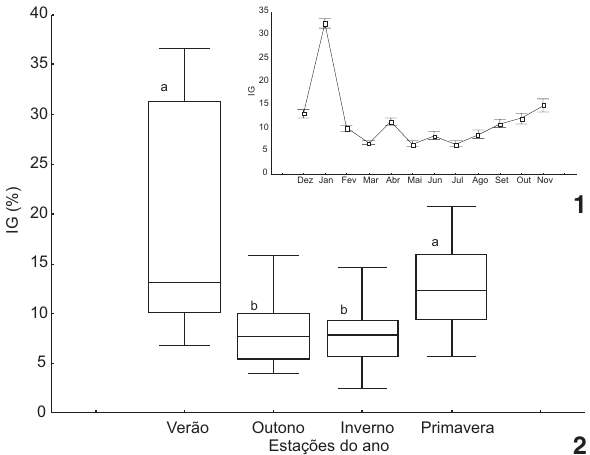
Figuras 1-2. Índice gonadossomático (mediana, 25%-75% e Min- Max) para a população E. lucunter (n = 40 por estação) nas diferentes estações do ano (1) e ao longo dos meses do ano (2). Letras diferentes indicam diferenças significativas pelo teste de Kruskal Wallis e teste Tukey não paramétrico (p < 0,05).